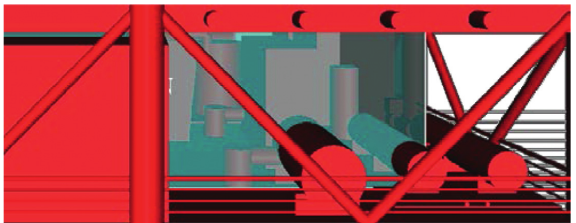
Figure 24: Gas explosion cloud example.